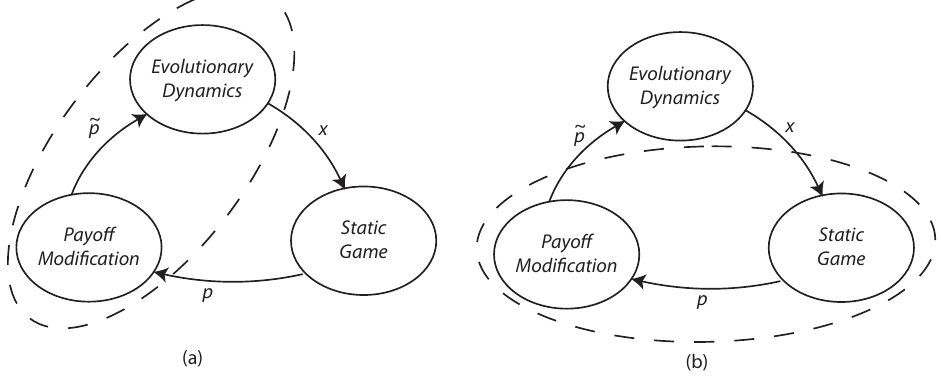
Figure 3. ( a ) Static game with dynamically modified evolution. ( b ) Standard evolution with dynamically modified